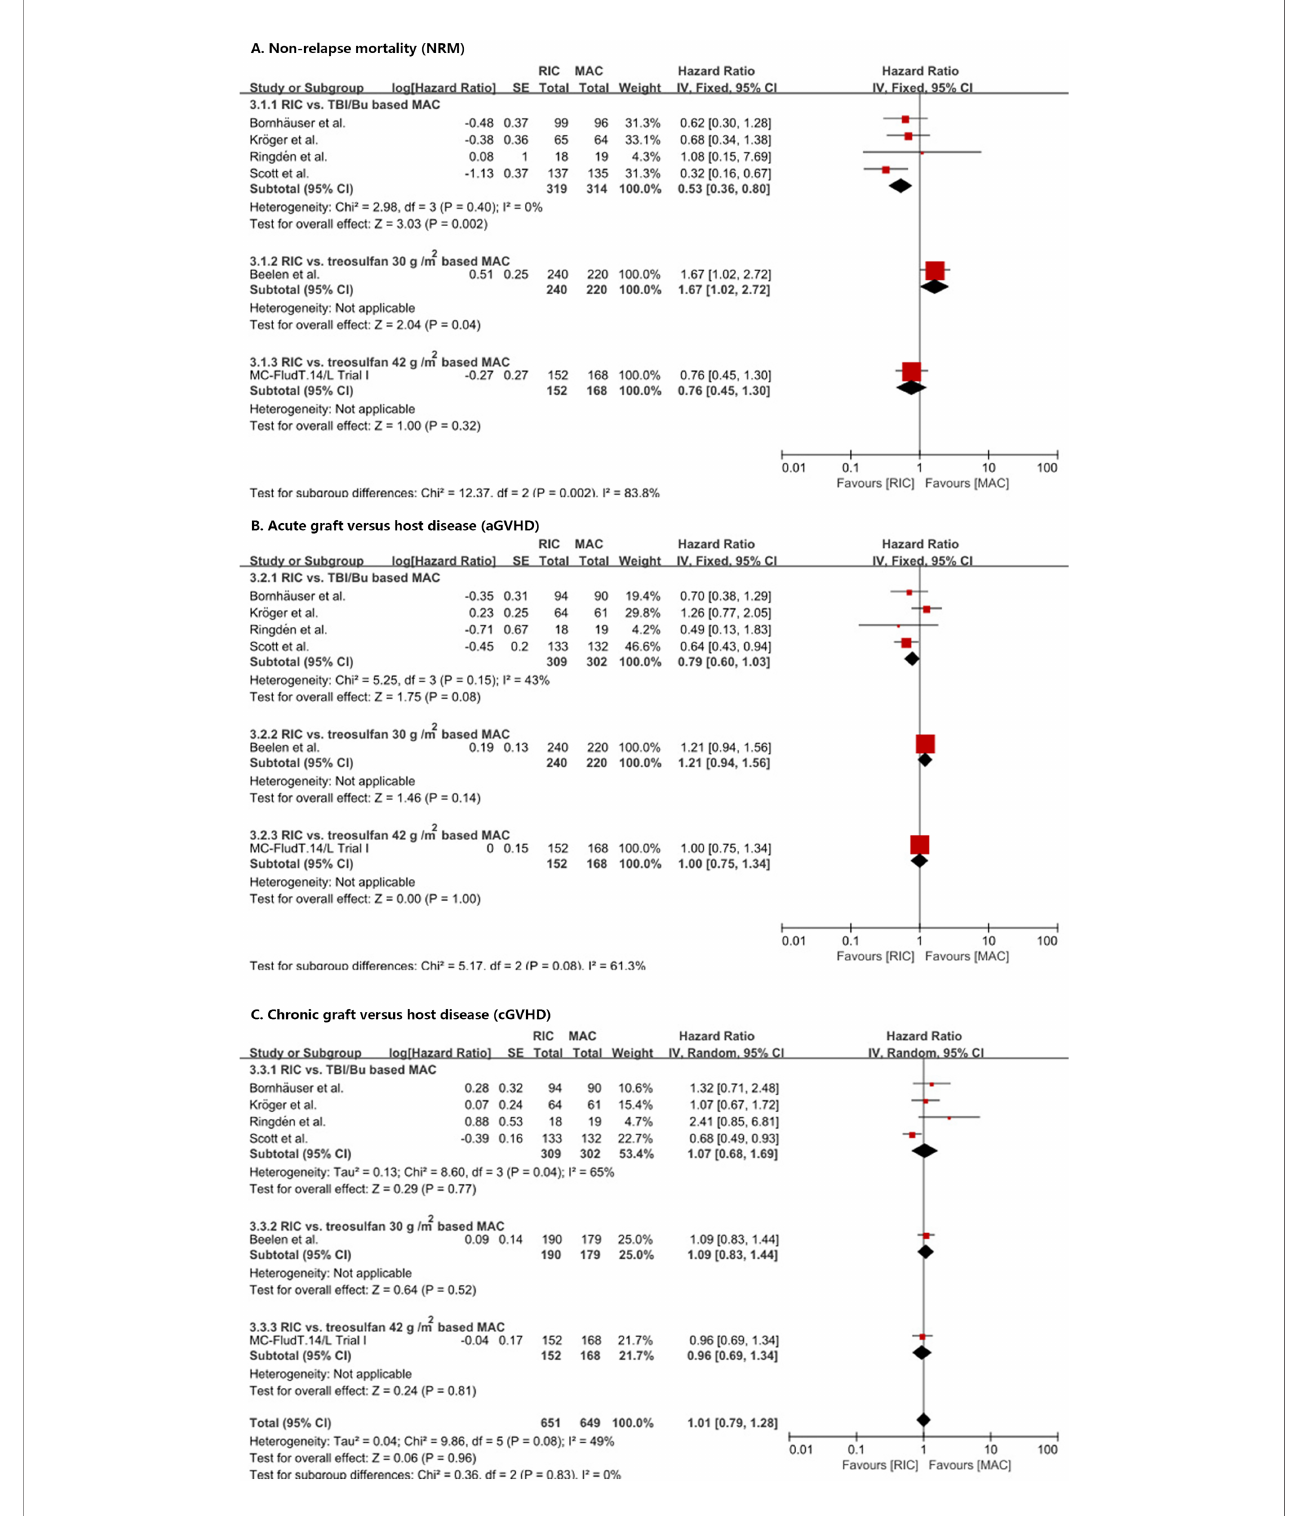
FIGURE 4 | Results of meta-analyses of NRM, aGVHD, and cGVHD endpoints. The forest plots showed that RIC signi fi cantly decreased NRM than TBI/Bu-based MAC (A) . RIC showed a trend to decrease aGVHD, but it was not statistically signi fi cant (B) . RIC had the same cGVHD as MAC (C) . RIC, reduced intensity conditioning; MAC, myeloablative conditioning; TBI, total body irradiation; Bu, busulfan.